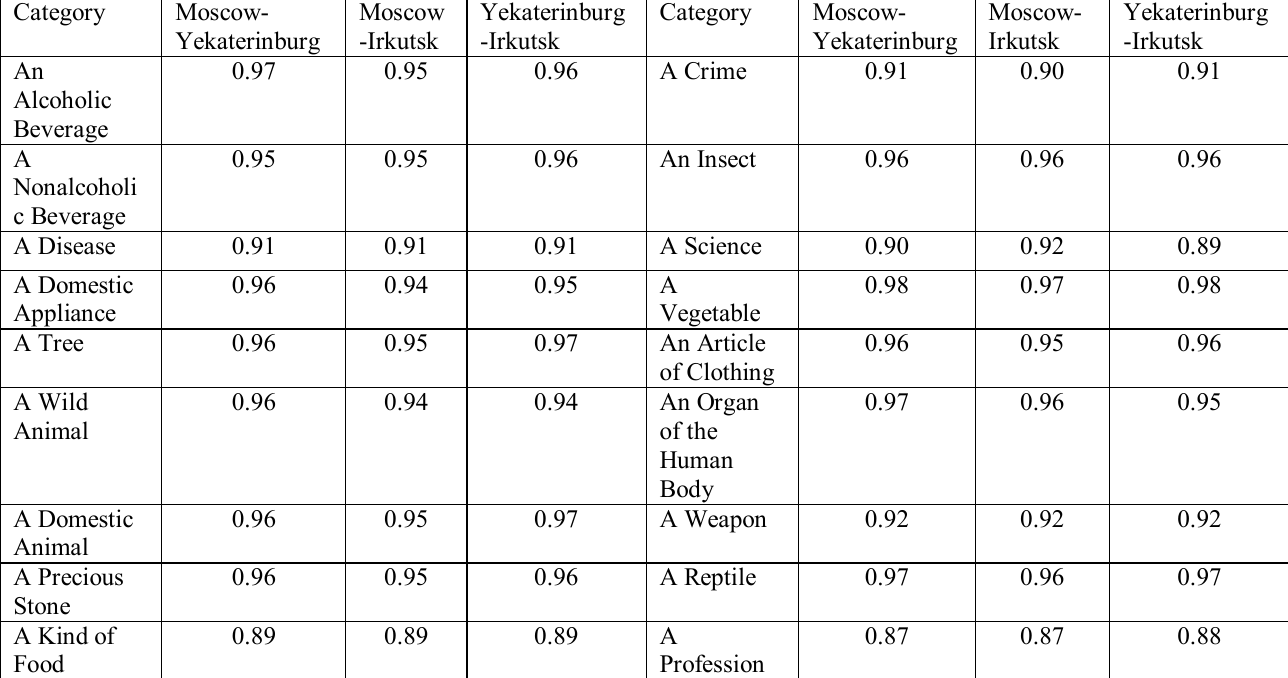
Table 1 – Hellinger Affinity coefficients as a measure of distance between frequency distributions